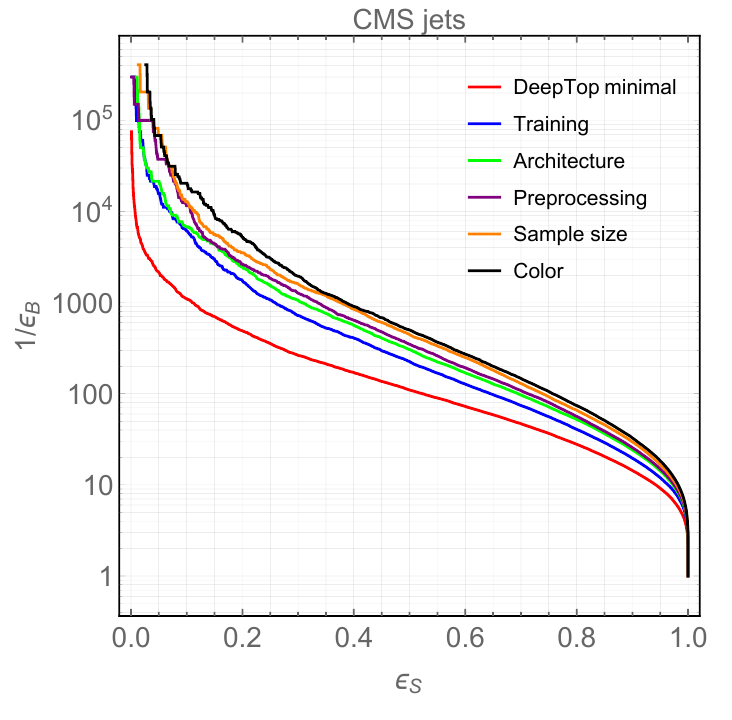
Figure 5 . Same as (cid:12)gure 4 but for the CMS jet sample.